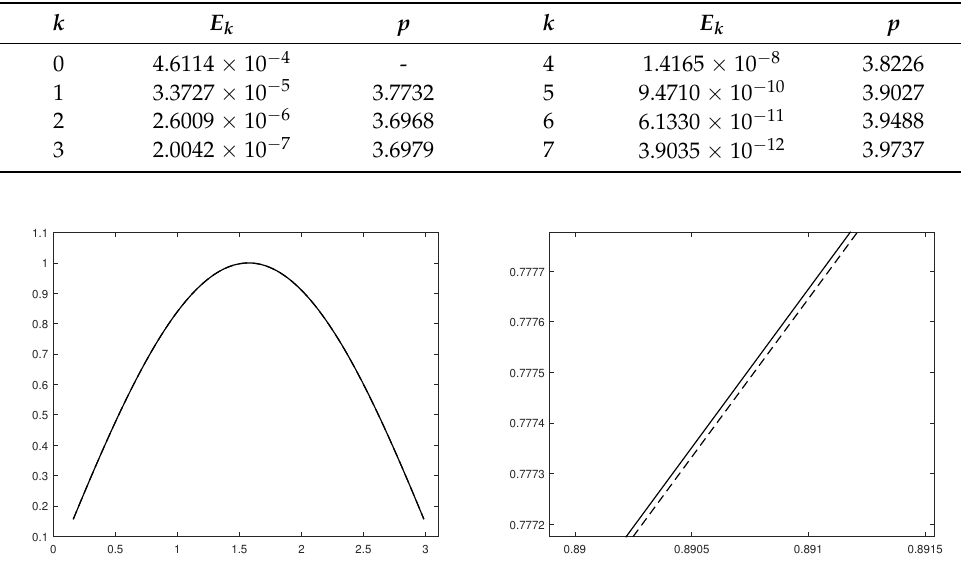
Figure 2. Solid line: function f ( x ) = sin ( x ) ; dashed line: PPH reconstruction obtained with the finest considered nonlinear grid. ( Left ) Original function and PPH reconstruction. ( Right ) Zoom of a part of the